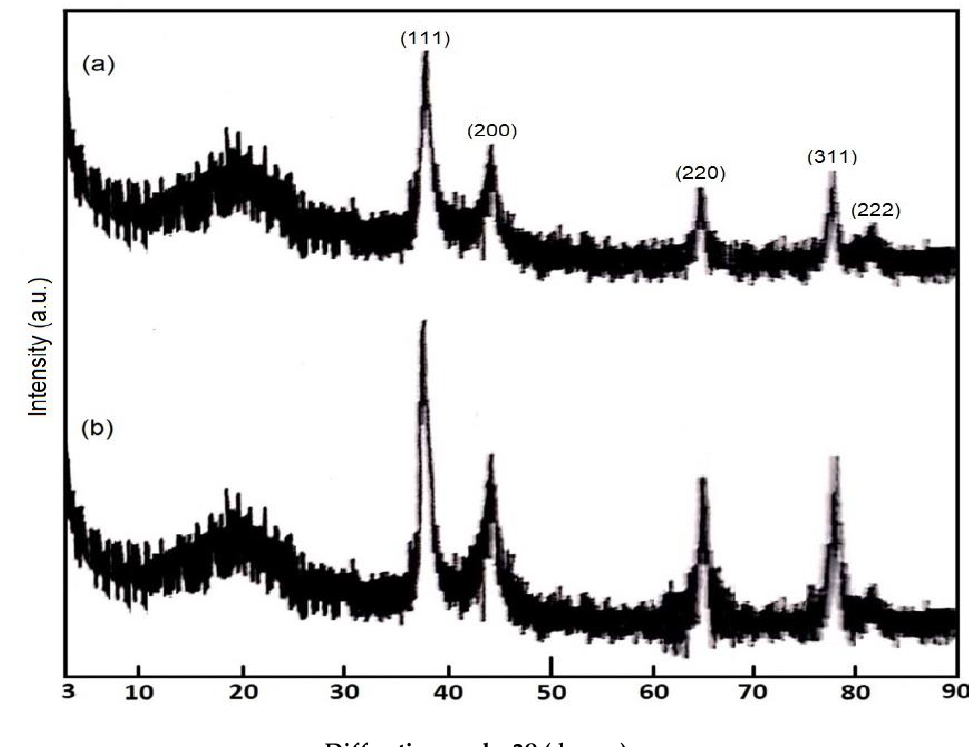
Figure 5. XRD patterns of: ( a ) H 31 /AgNPs3% and ( b ) H 31 /AgNPs5% composites.